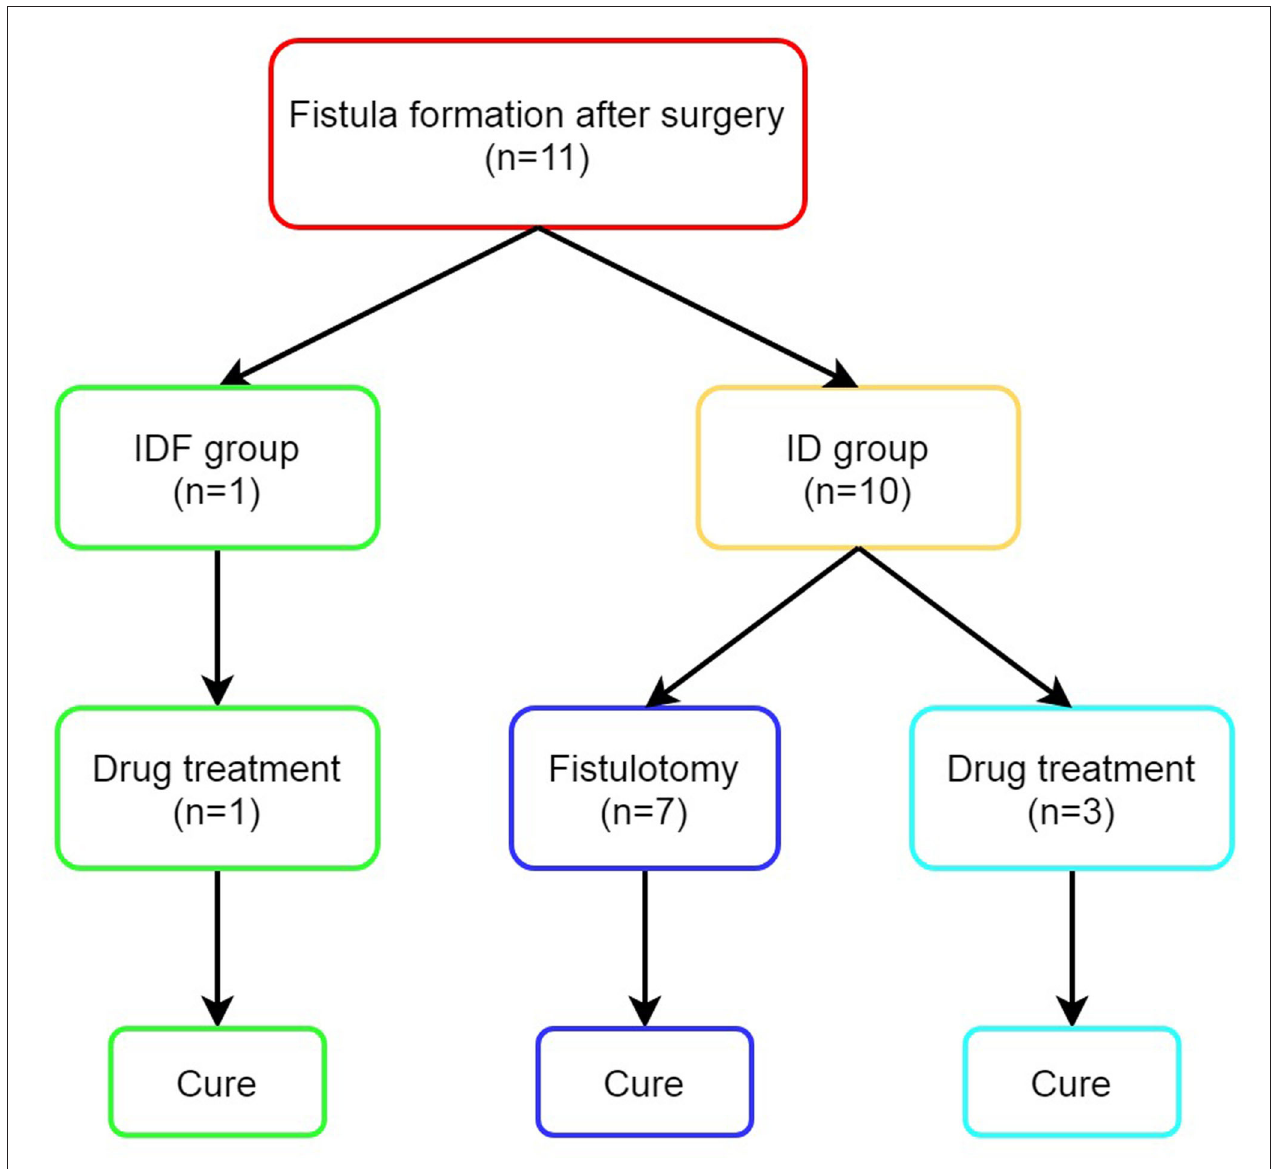
FIGURE 2 | Outcomes of patients with fistula formation after surgery. ID, incision and drainage; IDF, incision and drainage with primary